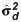
A correlation between the variance of phenotype explained by the GxE kinship matrix (σ^d2) and the inflation factor on GEI statistics (λGC) for human eQTL GxE GWAS data.The correlation is plotted for the three methods; OLS (A), One RE (B), and Two RE (C). Each dot is each probe, and x-axis is σ^d2 and y-axis is λGC. We estimate σ^d2 using the GCTA software, and only probes with σ^d2>10% are shown in the plots. The red line is a regression line between λGC and σ^d2, and Pearson correlation coefficient is indicated on the top right of the plot.